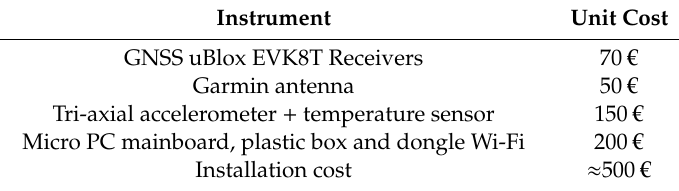
Table 2. Madonna del Sasso site. The unit cost of instrumentations and the estimate installation